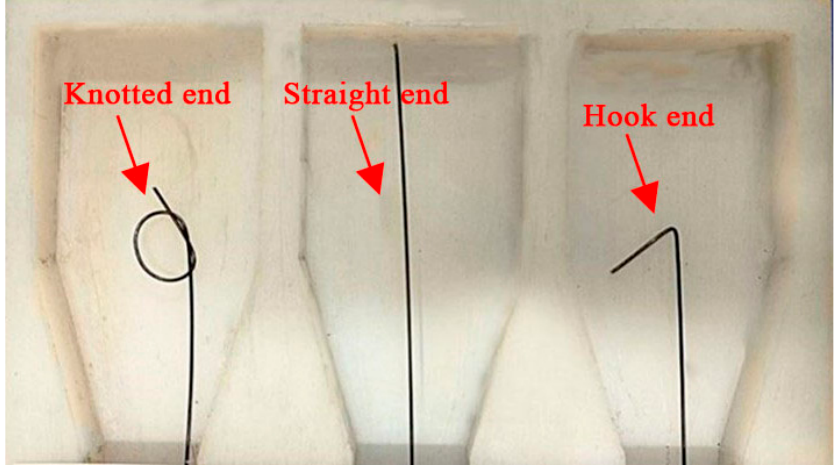
Figure 6. SMA fiber end shapes.